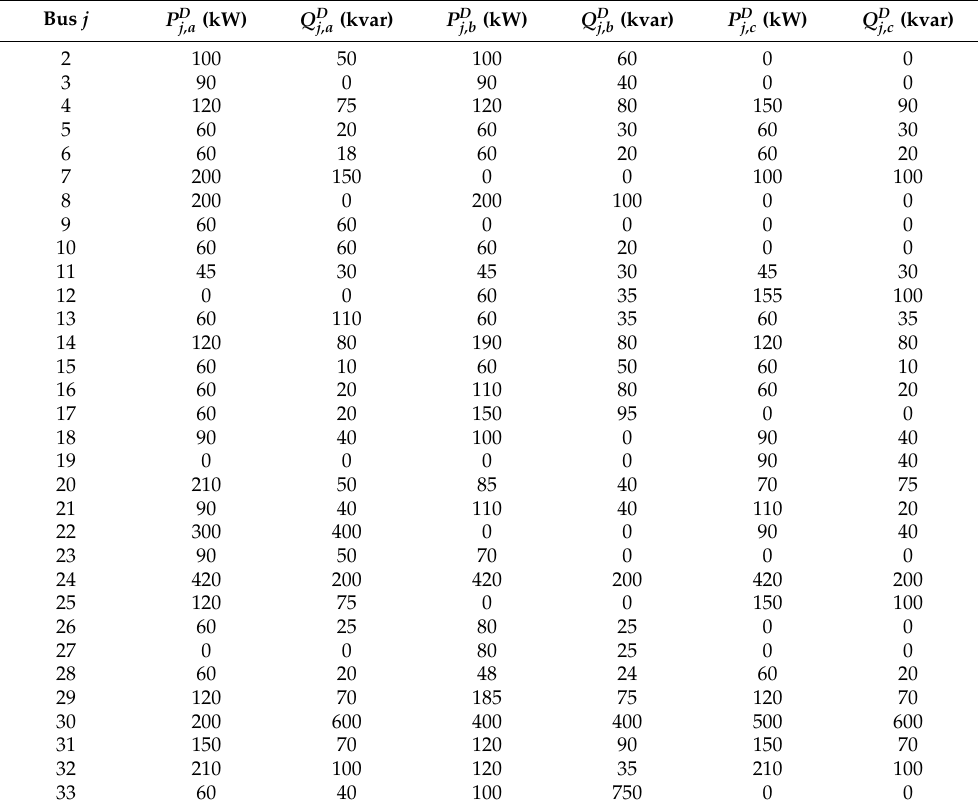
Table 14. Information corresponding to the 33-bus test system.